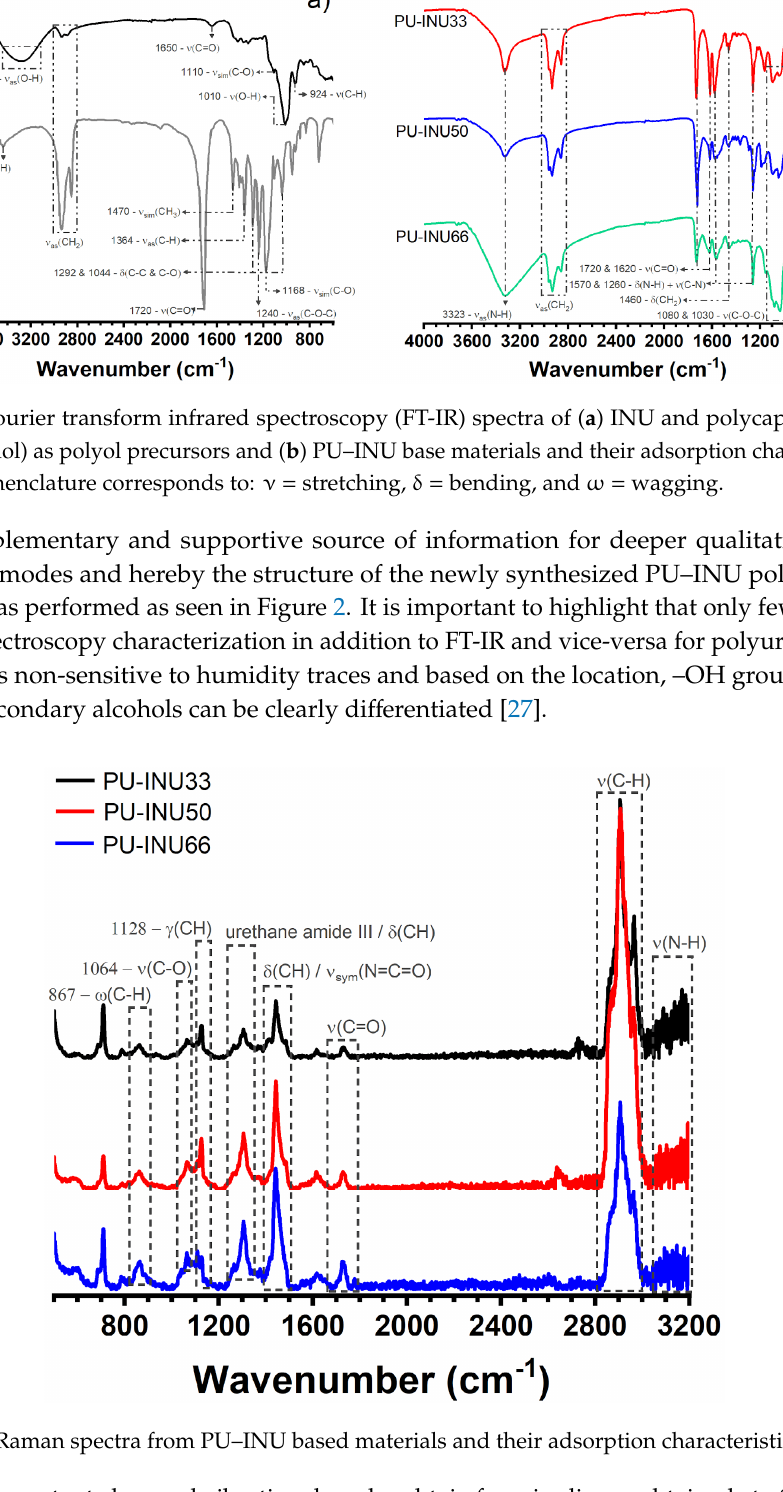
Figure 2. Raman spectra from PU–INU based materials and their adsorption characteristic bands.